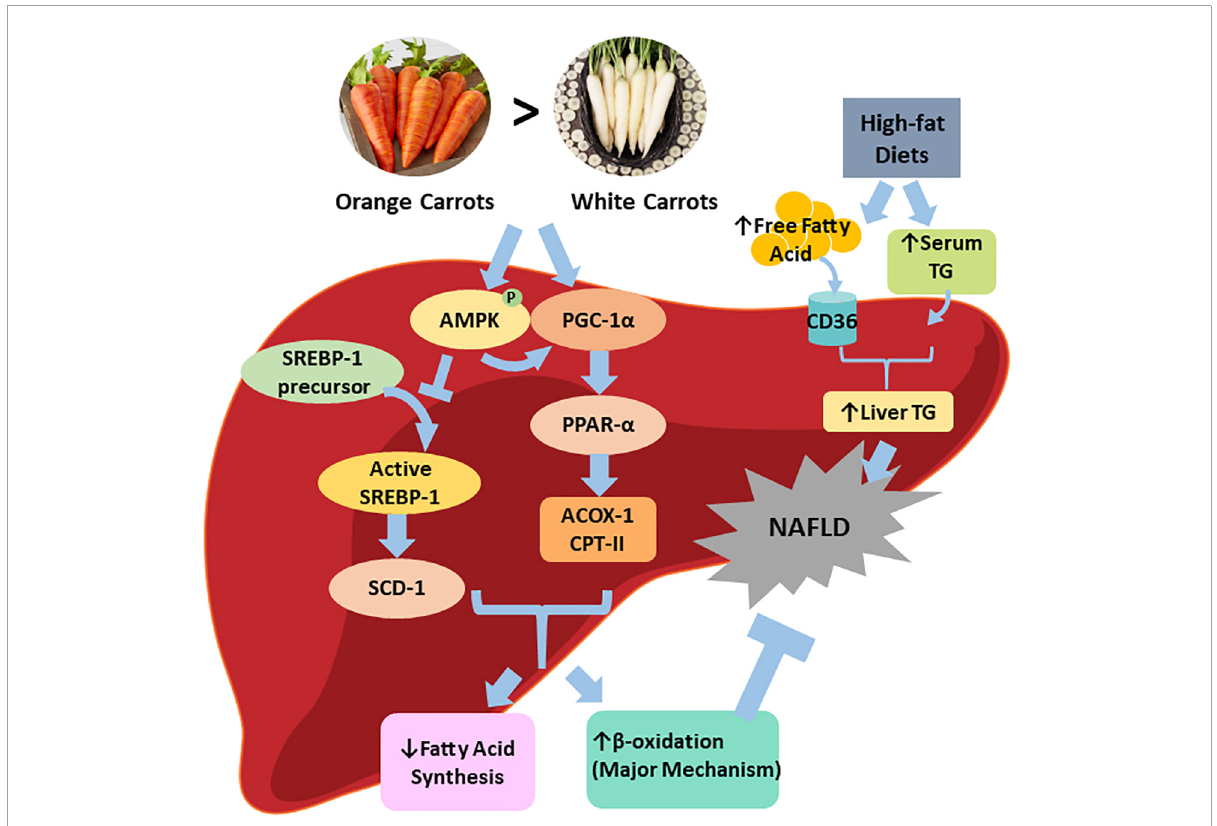
FIGURE7 Graphical representation of proposed pathway in which carotenoid-rich orange carrots alleviate NAFLD severity. Orange carrots rich in α -carotene and β -carotene combated the severity of hepatic steatosis brought on by a high-fat diet by partially inhibiting fatty acid synthesis and significantly enhancing β -oxidation proteins, due to promotion of master regulators of hepatic lipid metabolism (i.e., p-AMPK, PGC-1 α , PPAR α